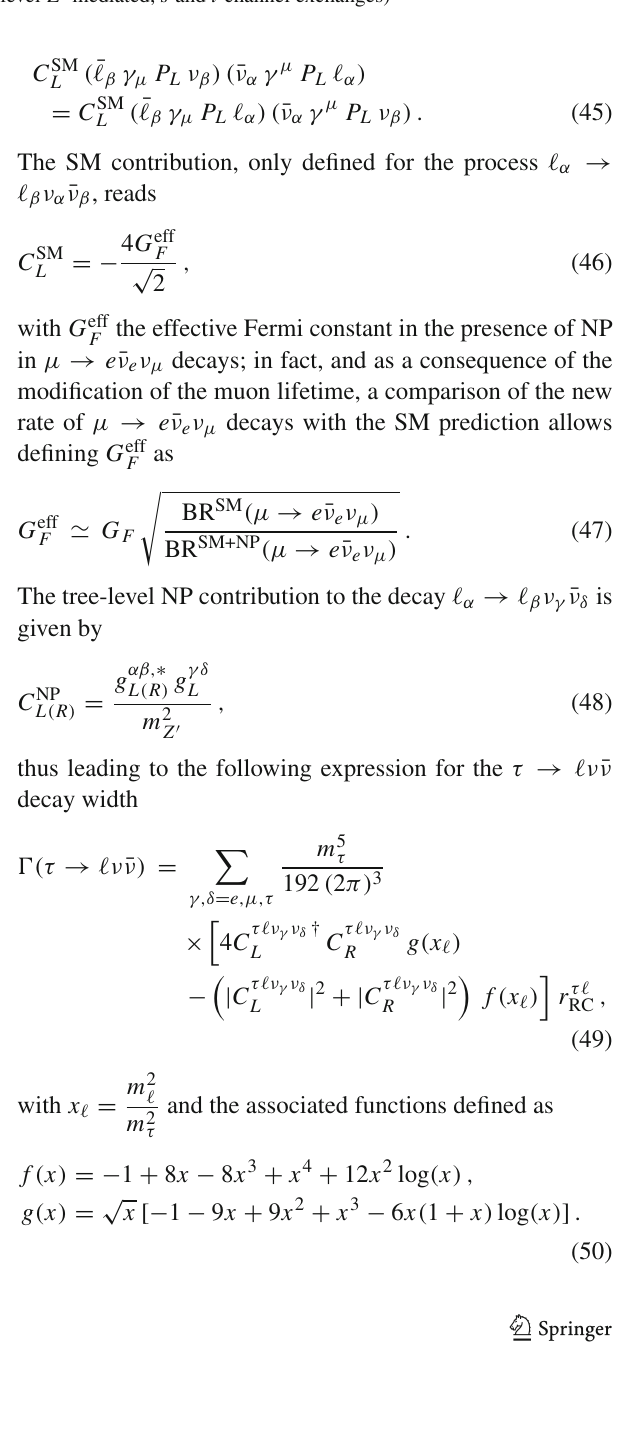
Fig. 2 Feynman diagrams for Muonium-antimuonium oscillations (tree-level Z (cid:2) mediated, s and t channel